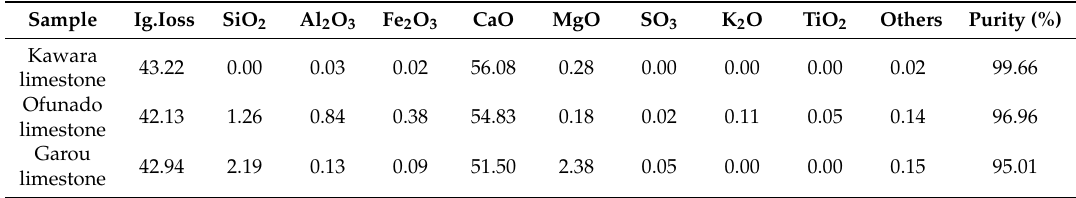
Table 1. Chemical compositions (mass%) of different natural limestone samples. (measured by a ZSX Primus II Scanning X-ray fluorescence analyzer, Rigaku, Japan).